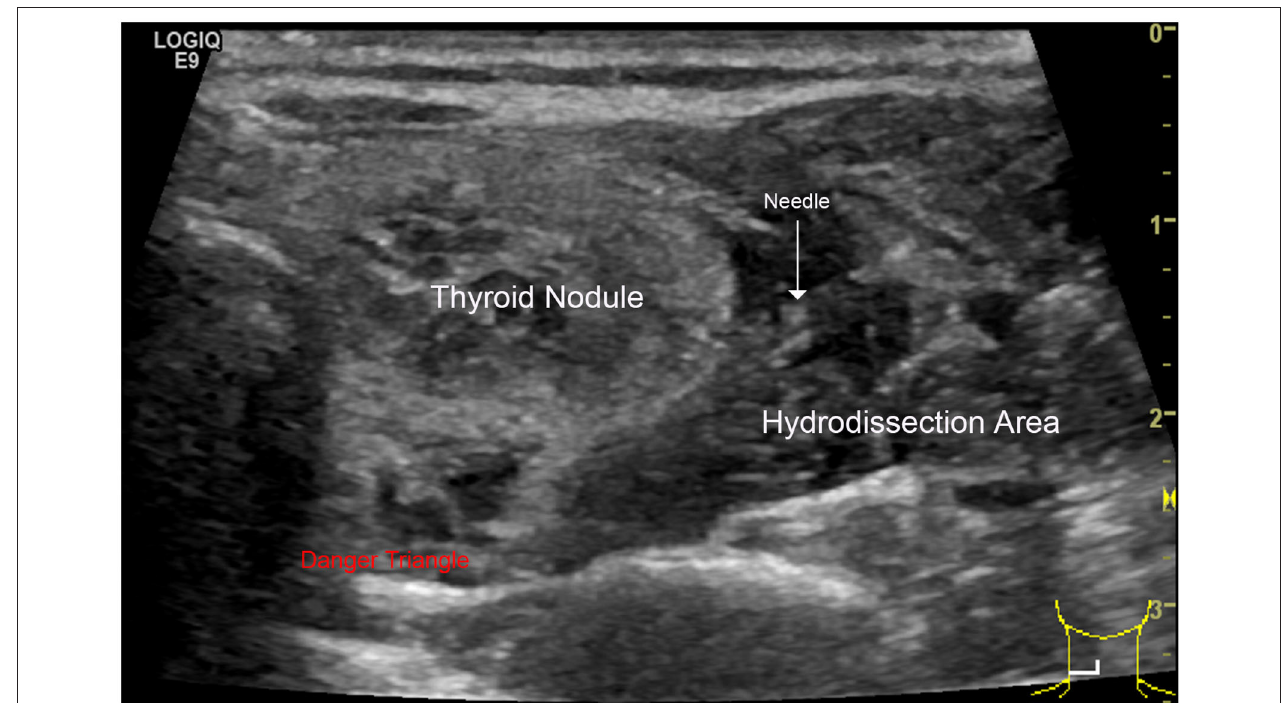
FIGURE 1 | Hydrodissection technique: this technique consists of a pressurized injection of 5% glucose between the danger triangle and the thyroid to reduce possible nerve injury caused by RFA hyperthermia.